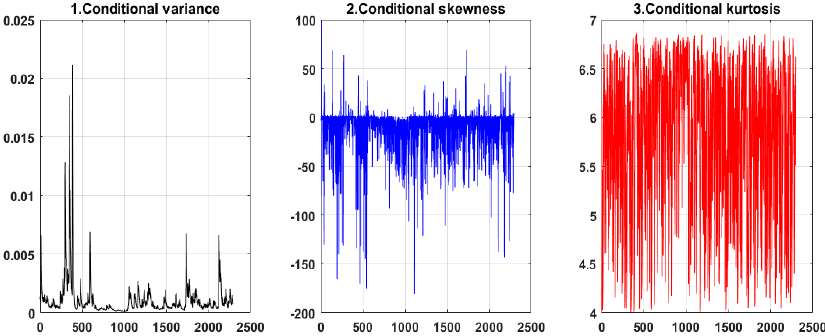
Figure 3. Time-varying, high-moment fluctuation of the carbon price identified by the NA- GARCHSK